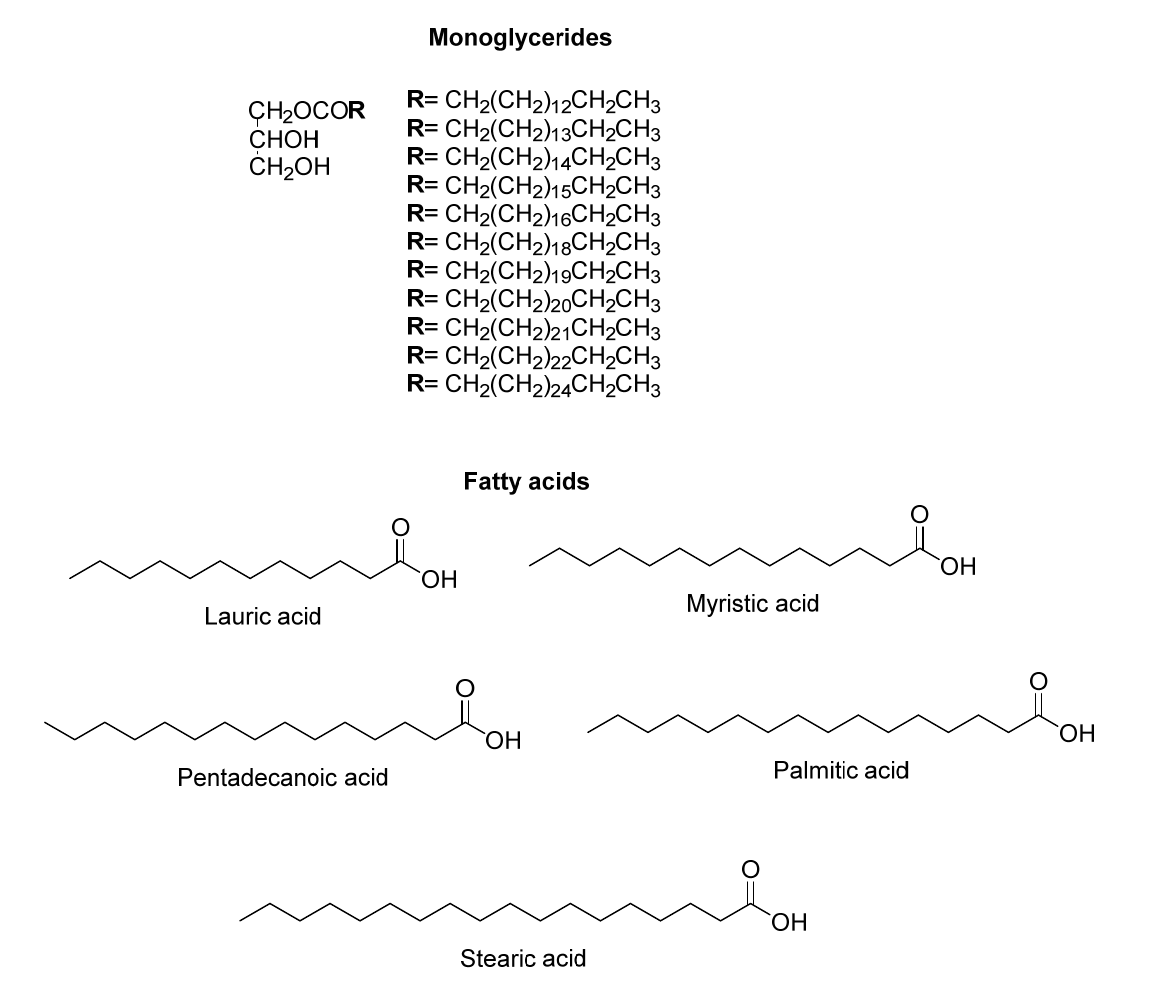
Figure 9. Monoglycerides and fatty acids with hypoglycemic effects of I. sonorae.